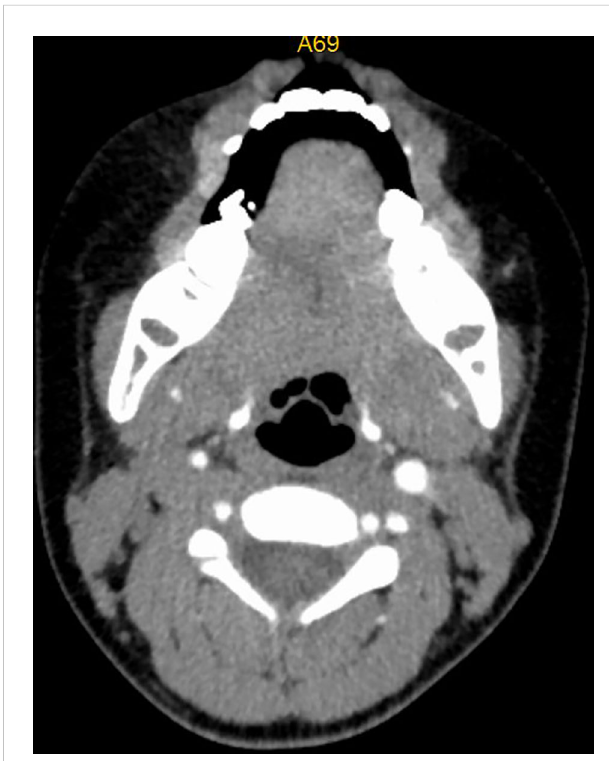
FIGURE 3 CT image of No. 8 patient after embolization treatment, hemangioma disappeared, no airway stenosis.